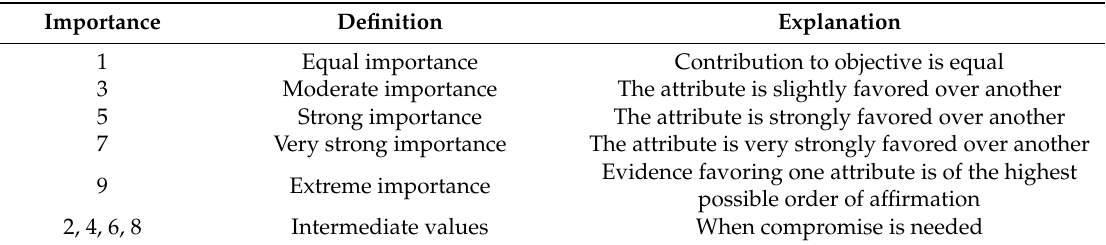
Table 1. Pairwise comparison point based rating scale